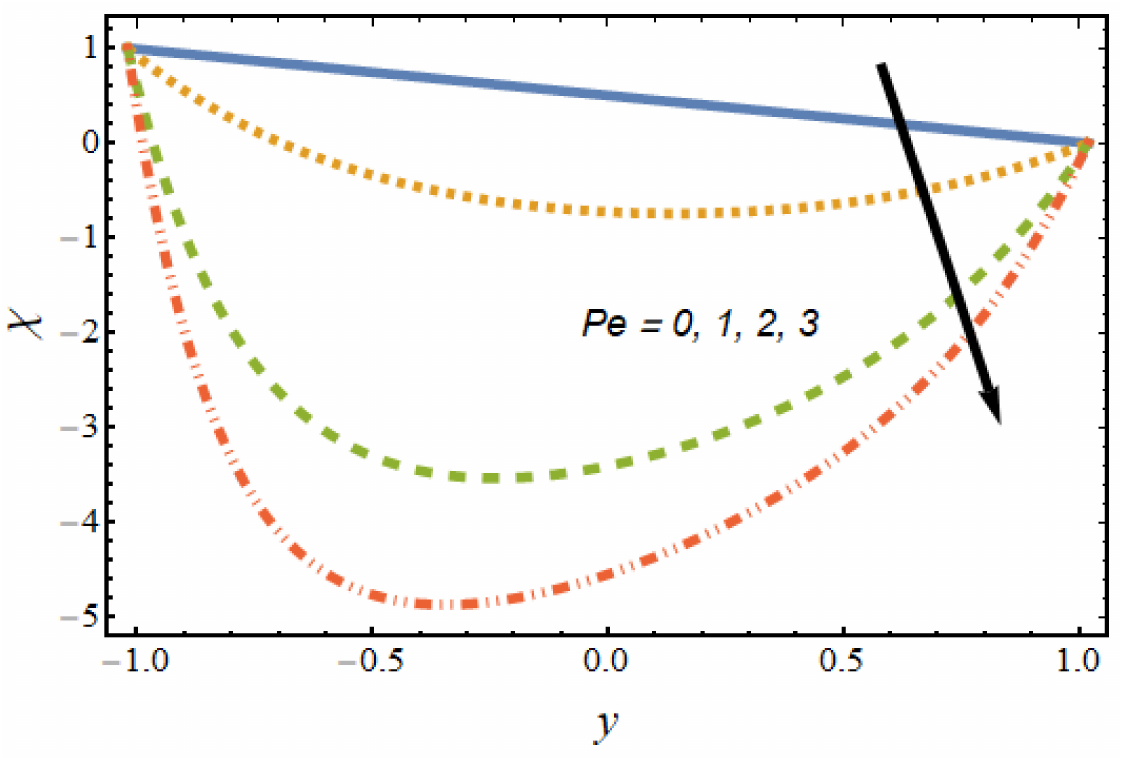
Figure 17. Motile microorganism profile for various values of the Peclet